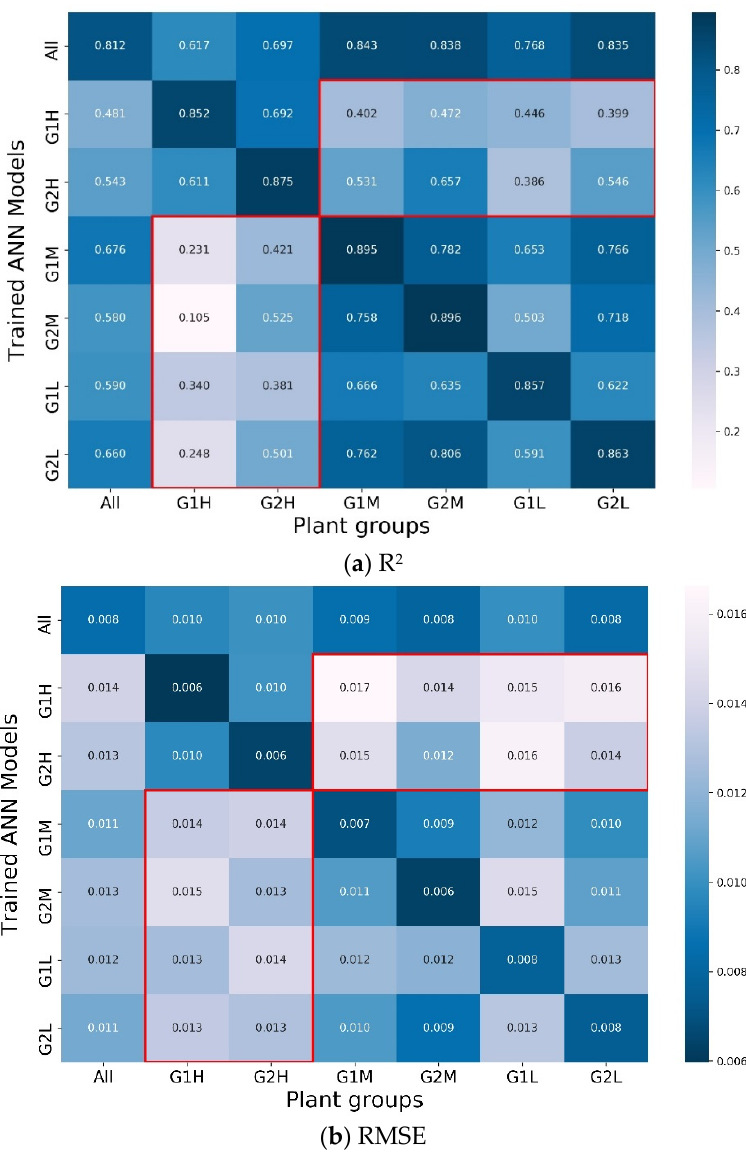
Figure 8. Accuracy heatmaps of R2 and RMSE of ANN models for NDVI. Red boxes: the region with relatively poor predictive results.